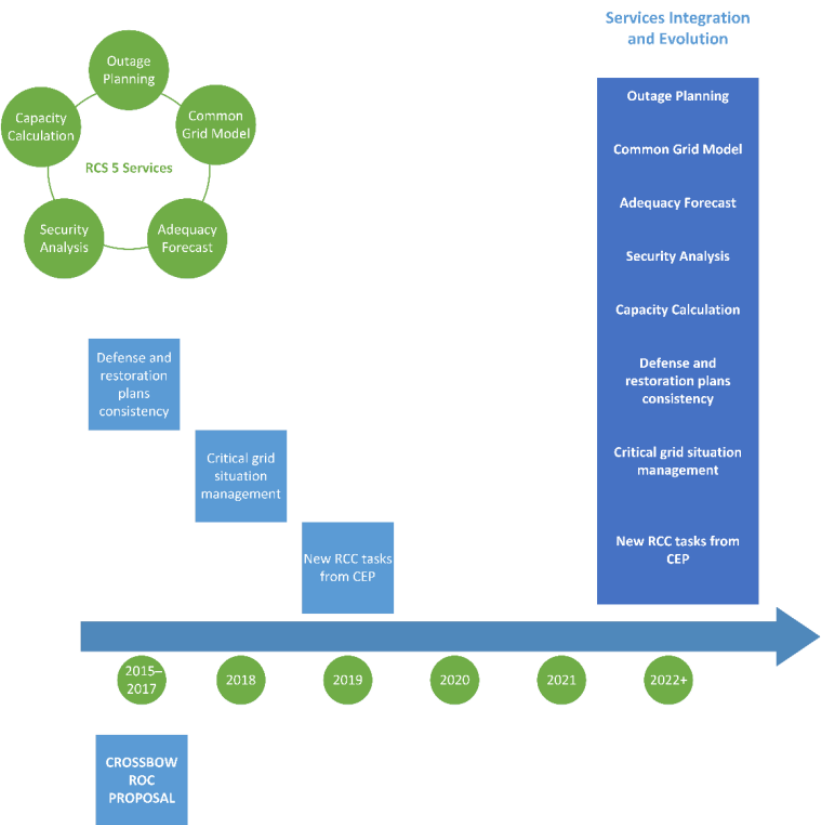
Figure 1. Chronology of regional cooperation.